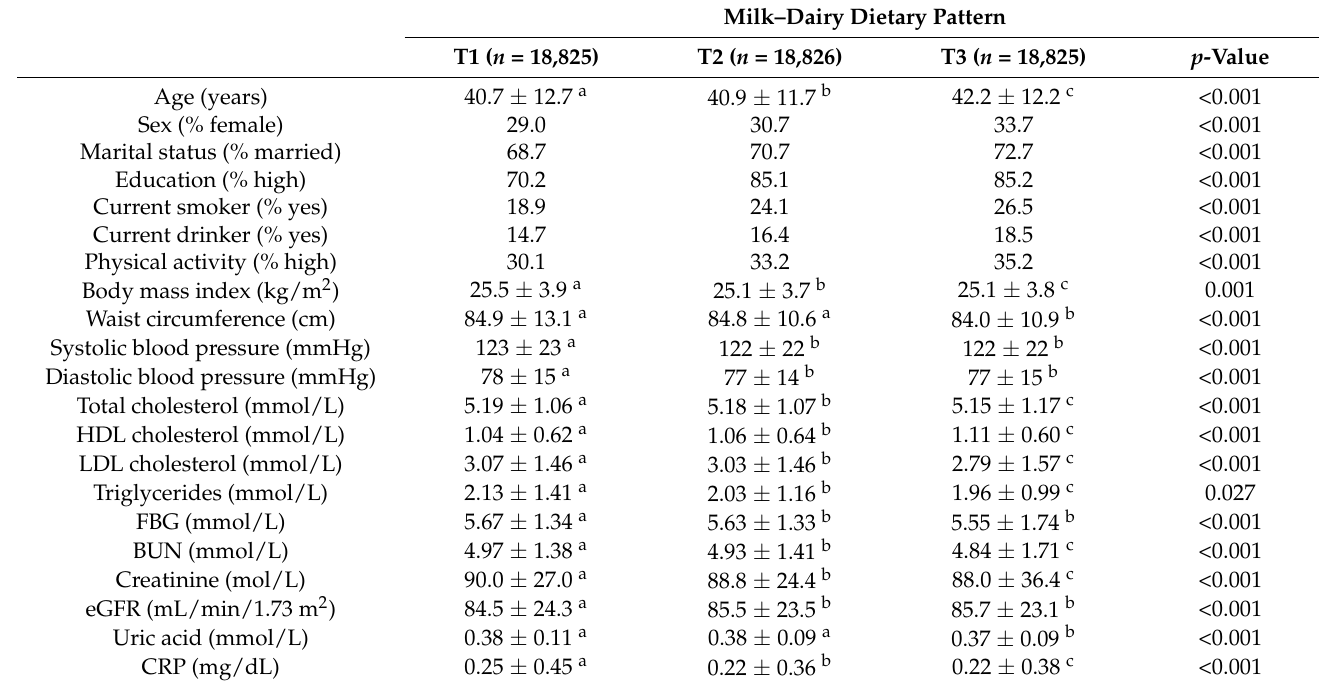
Table 6. Characteristics of the subjects across tertiles of the milk–dairy dietary pattern ( n = 56,476) 1